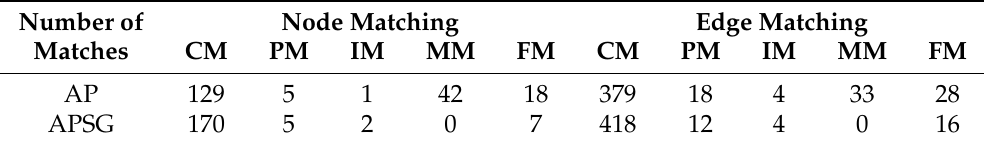
Table 5. Number of matching results |M ( · ) | in AP and APSG schemes.